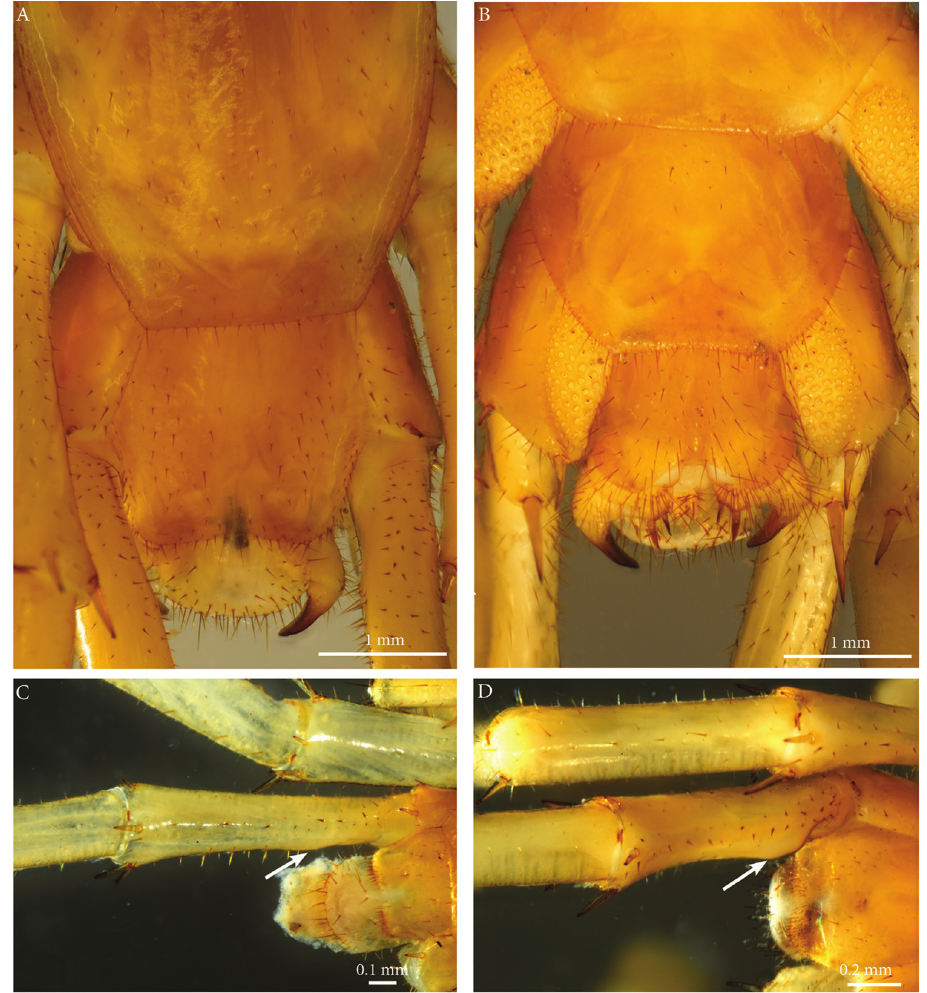
Figure 6. Eupolybothrus liburnicus sp. n., A, B, female paratype NHMW 8409. A Intermediate and terminal tergite, dorsal view B Female terminal sternite and gonopods C, D Iimmature males C CHP544 D CHP543. Arrows point to incipient proximal